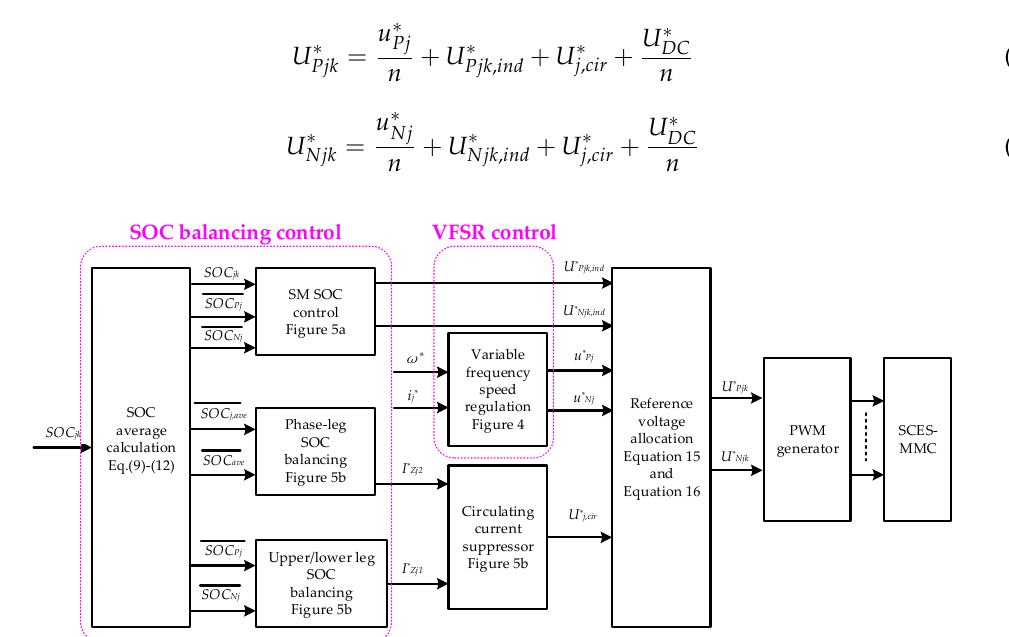
Figure 6. Overview of system control structures for SCES-MMC.